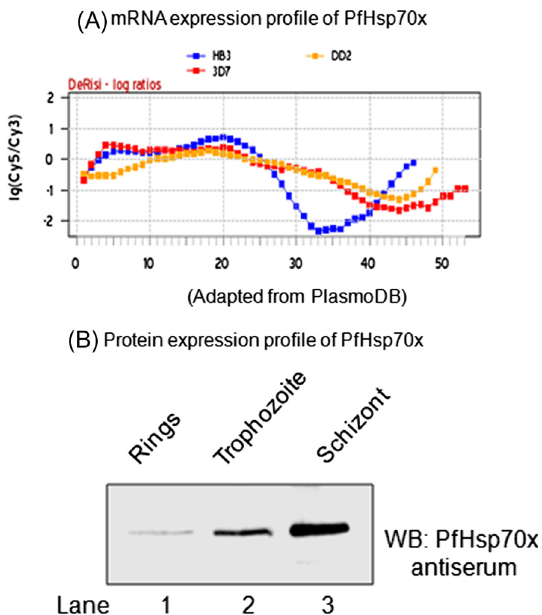
Figure 4. Expression profile of PfHsp70-x : (A) mRNA expression profile of PfHsp70- x during the 48 h asexual cycle from three different strains of P. falciparum (red: 3D7, blue: HB3 and yellow: DD2), adapted from PlasmoDB. (B) Western blot analysis of total parasite lysate at different stages of P. falciparum asexual cycle. Ring stage (2–8 hpi), Trophozoite stage (24–30 hpi) and Schizont stage (36–48 hpi); hpi: hours